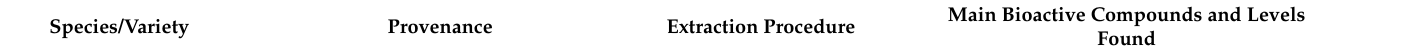
Table 4. Bioactive composition and extraction procedures of Opuntia spp. flowers and